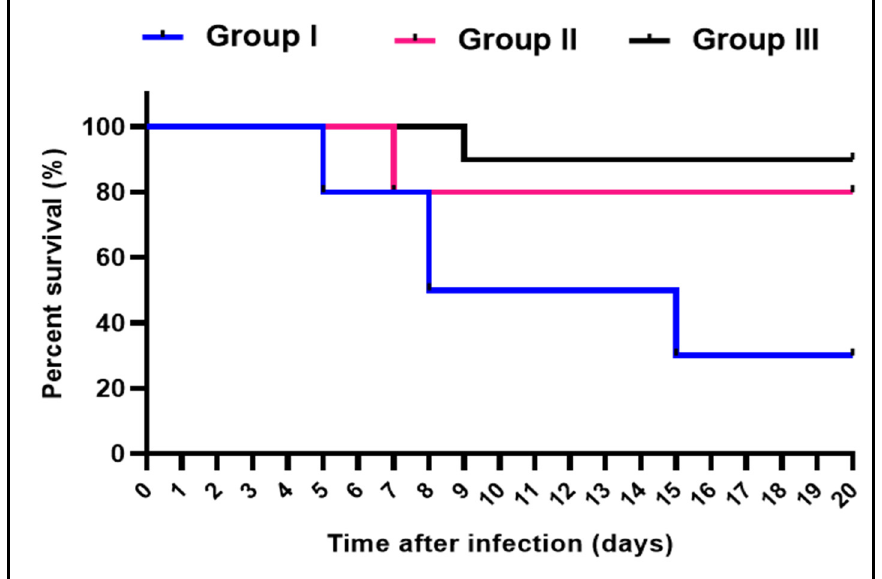
Figure 7. Kaplan–Meier survival curve of the experimental groups.